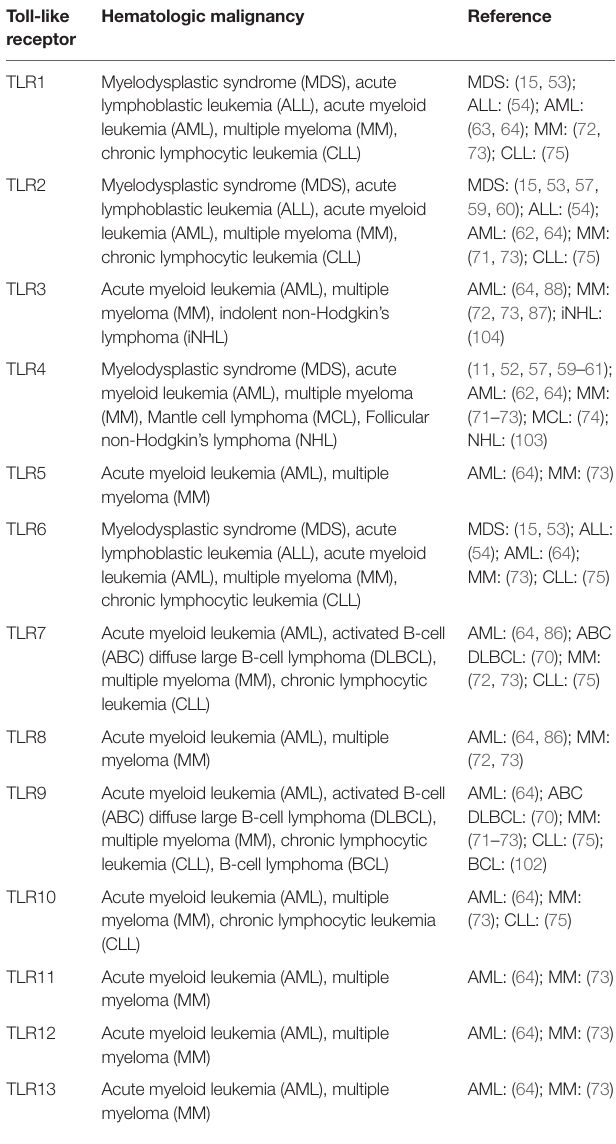
TABLe 1 | Overview of toll-like receptors associated with hematologic malignancies. Toll-like Hematologic malignancy receptor